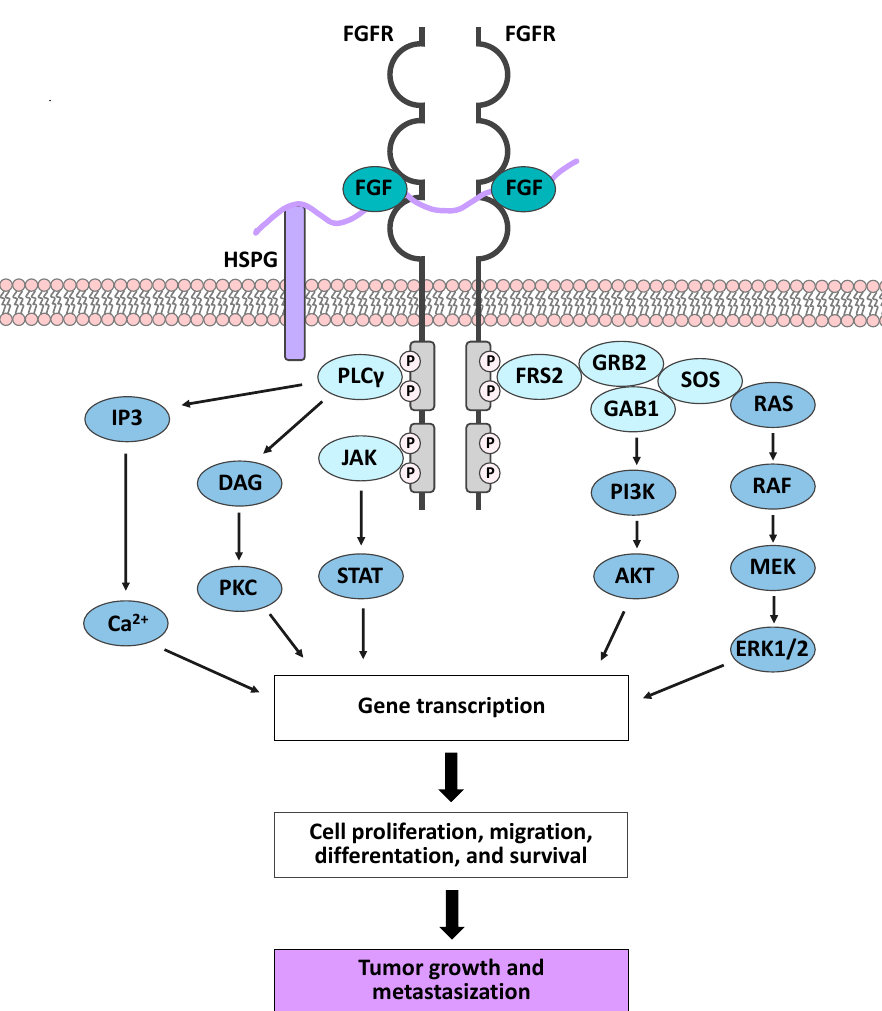
FGF-FGFR-heparan sulfate proteoglycan (HSPG) ternary complexes and their subsequent dimerization (Figure 2) [33,36].